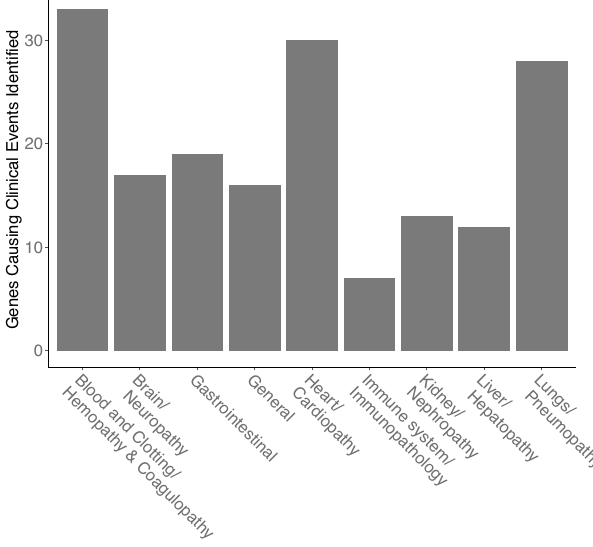
Figure 4. An overview of clinical indications. The distribution of top-level Clinical Indication shows that proteins with structural homologies span a wide range of clinical